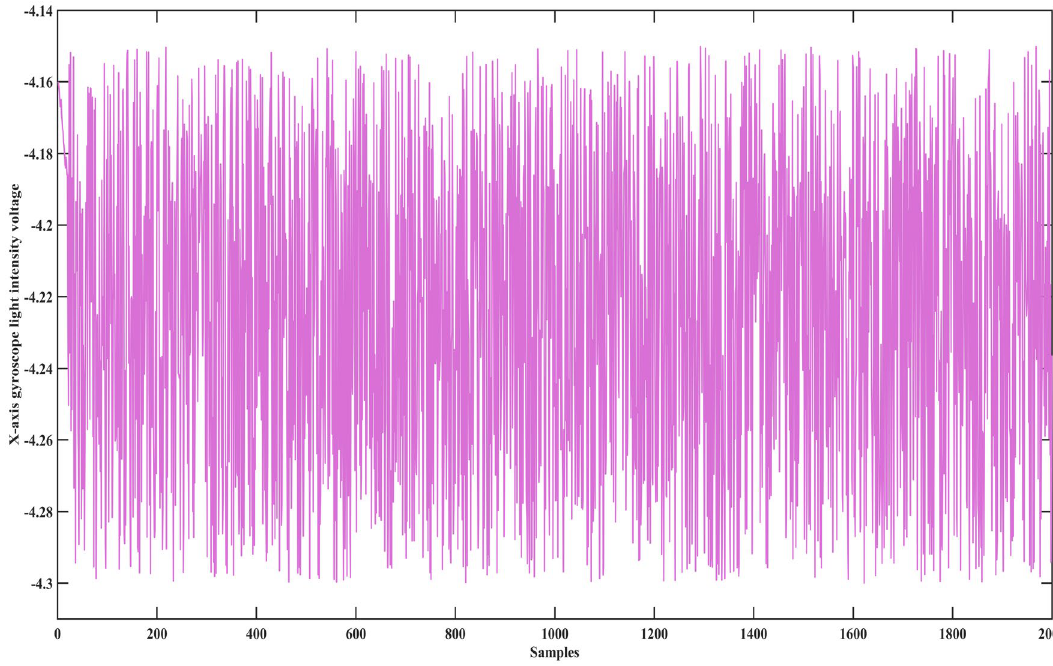
Figure 3. The X-axis gyroscope light intensity voltage of the laser gyro.